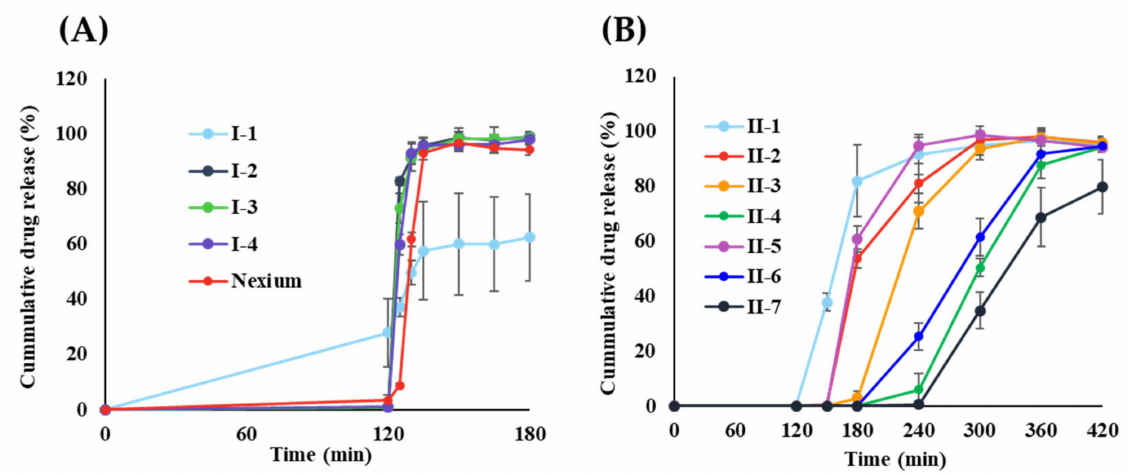
Figure 4. The release profile of coated EMP mini-tablet (mean ± standard deviation, n = 6). ( A ) ELD-55 coated EMP mini-tablet (1st release mini-tablet) with different coating ratio; ( B ) ES- 100/EL-100 coated EMP mini-tablet (2nd release mini-tablet) with different coating ratio and different ratio of